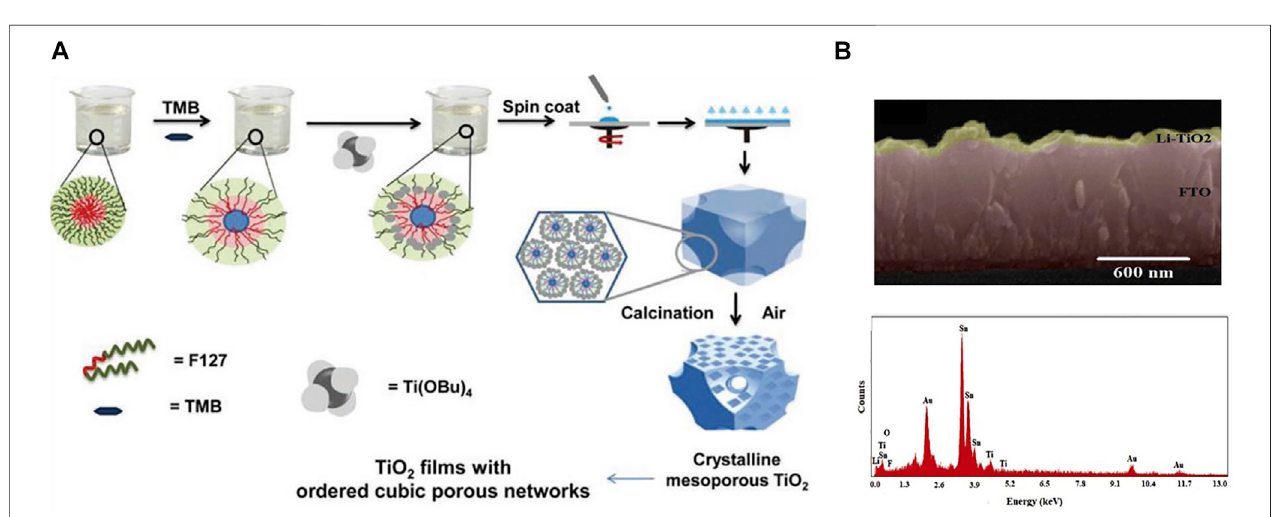
FIGURE 5 | (A) Preparation of TiO 2 fi lms by evaporation induced self-assembly combining the pore-enlarging effects of the swelling agent. (B) Cross-section and EDX spectrum of lithium doped TiO2 device.